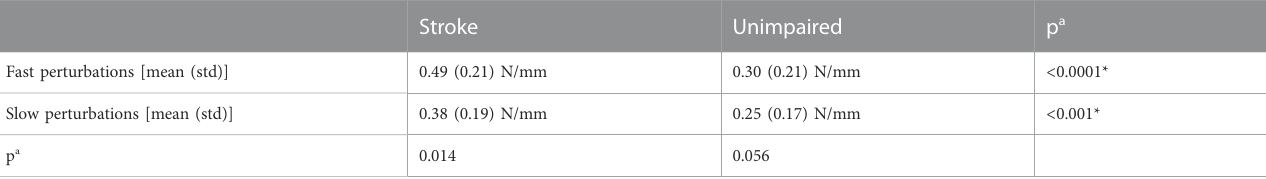
TABLE 3 Stiffness ( k ) results considering all the fast or slow perturbations throughout the exercise in the stroke and unimpaired groups. Stroke p a Fast perturbations [mean